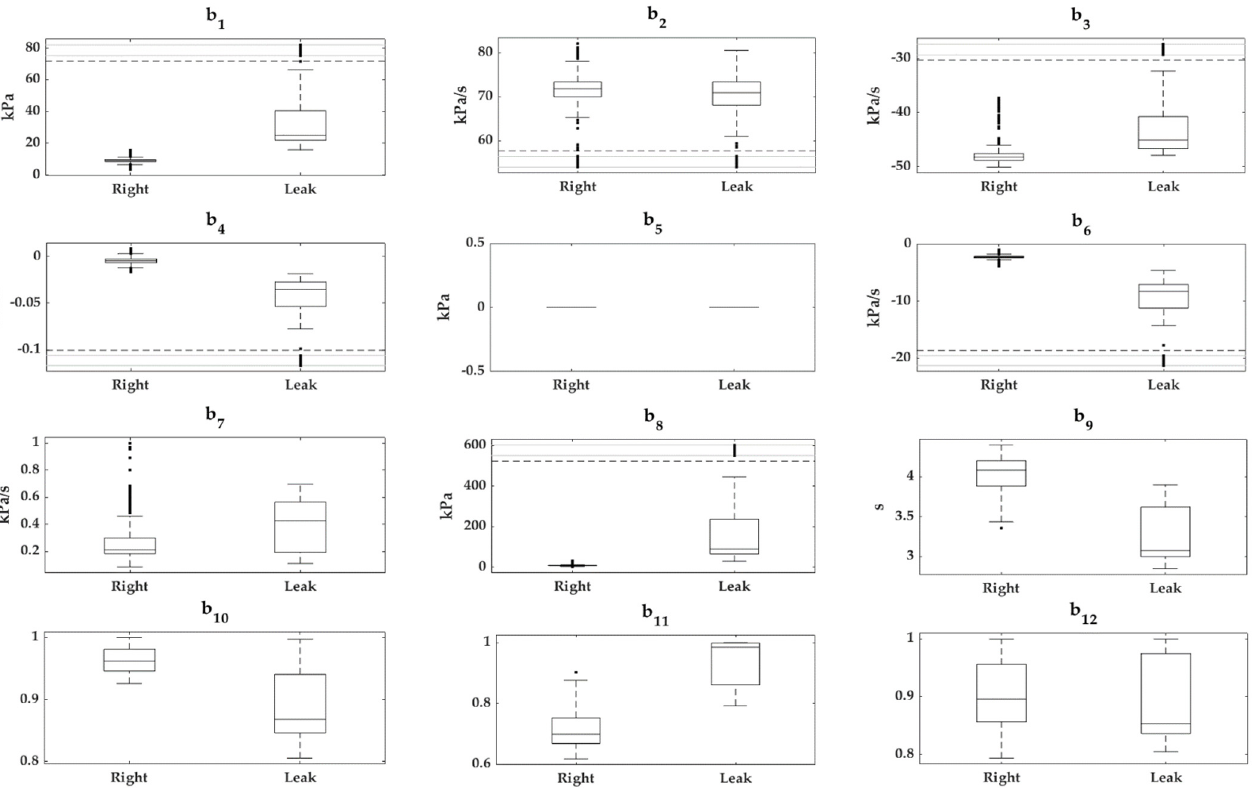
Figure 6. Box-and-whisker plots of quantitative features extracted ( b 1 – b 12 ) from the bellows signals. The “ Right ” and “ Leak ” groups are represented for each feature; b 13 is not presented due to its categorical nature. For additional information on the extracted features see Appendix A.